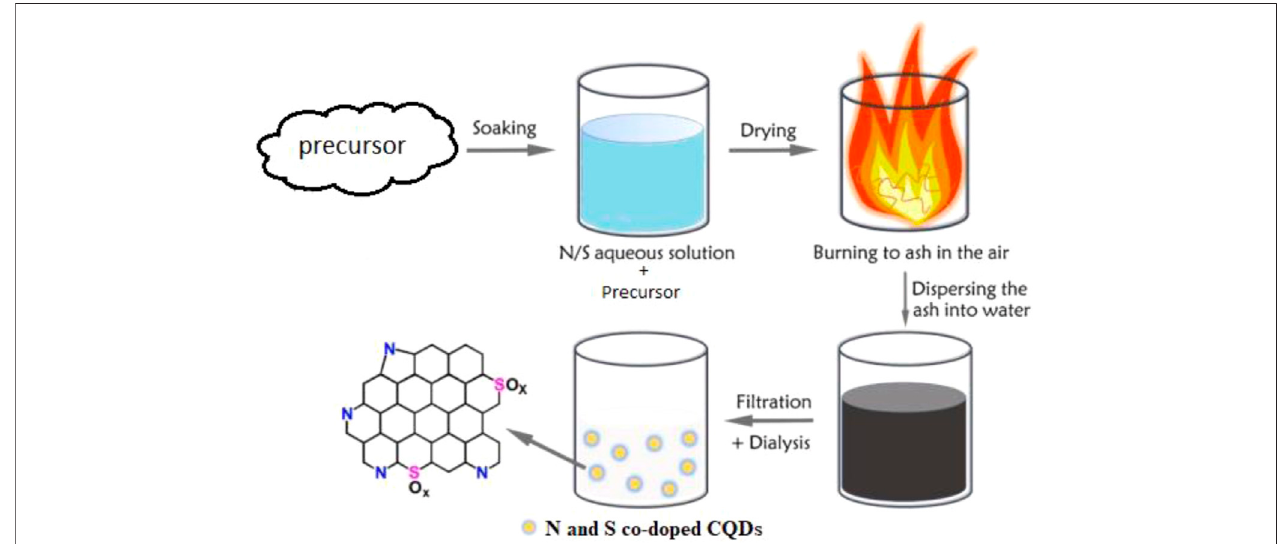
FIGURE 5 | Schematic illustration of the preparation of N/S co-doped CQDs. This was adapted and modi fi ed with the permission from Cheng et al. (2019).